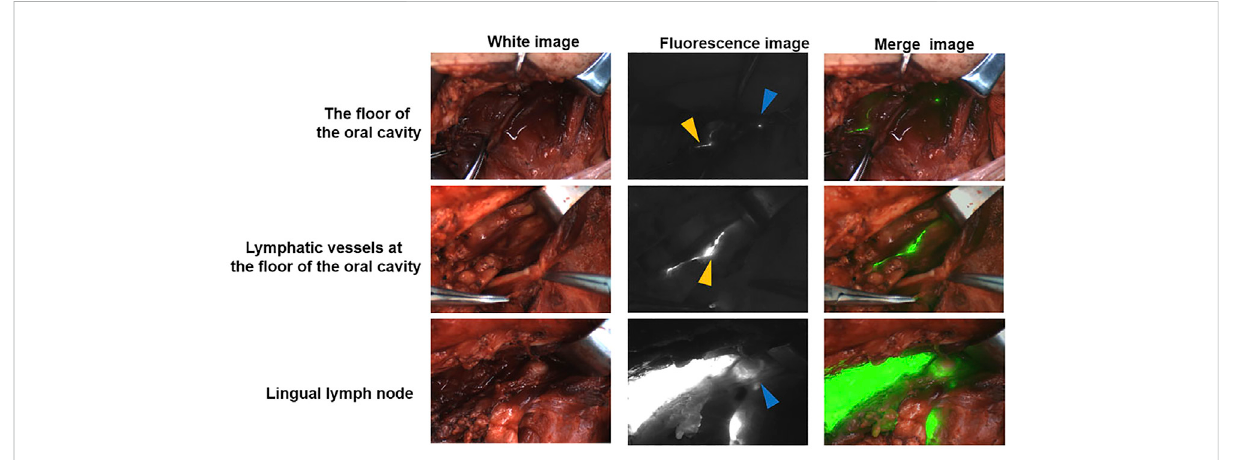
FIGURE 1 A pathway from the fl oor of the mouth to the cervical lymph via LLN The blue triangle indicates the LLN. The yellow triangle indicates the lymphatic duct.